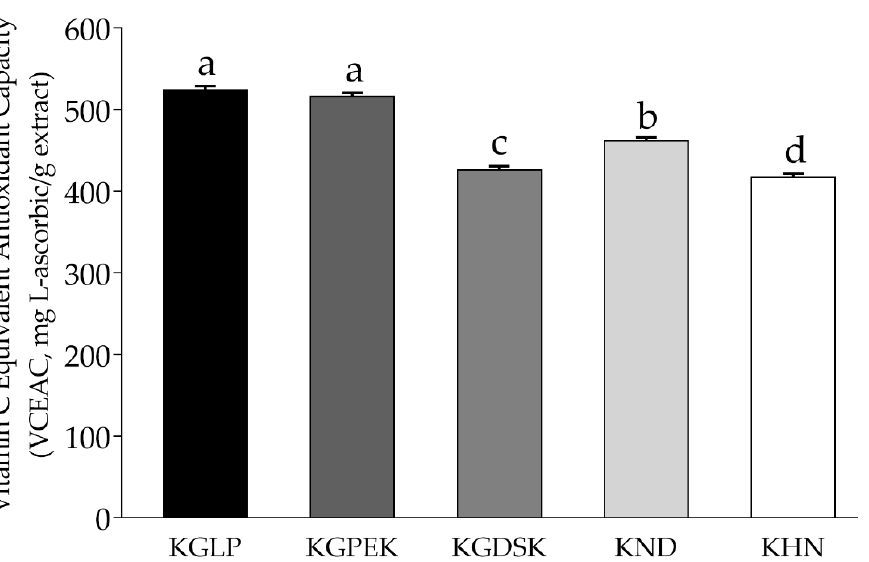
Figure 1. ABTS radical scavenging activity of purple rice extracts. The values are expressed as mean ± SD ( n = 3). Different superscript letters indicate significant difference at p < 0.05. VCEAC: Vitamin C equivalent antioxidant capacity.